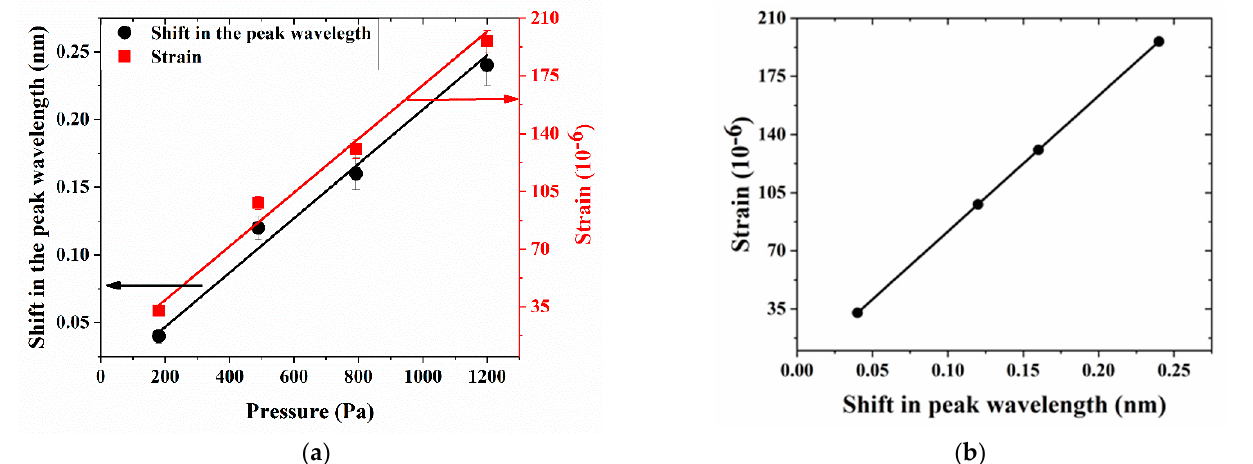
Figure 4. ( a ) Variation of peak wavelength and strain with respect to applied pressure. ( b ) Sensor relationship between the strain as a function of the peak wavelength shift.